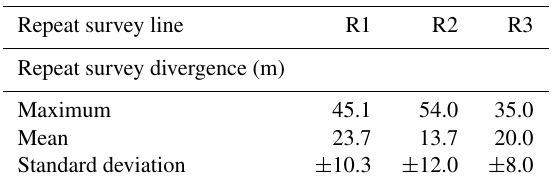
Table 2. Analysis of navigational divergence and associated vari- ability in bed